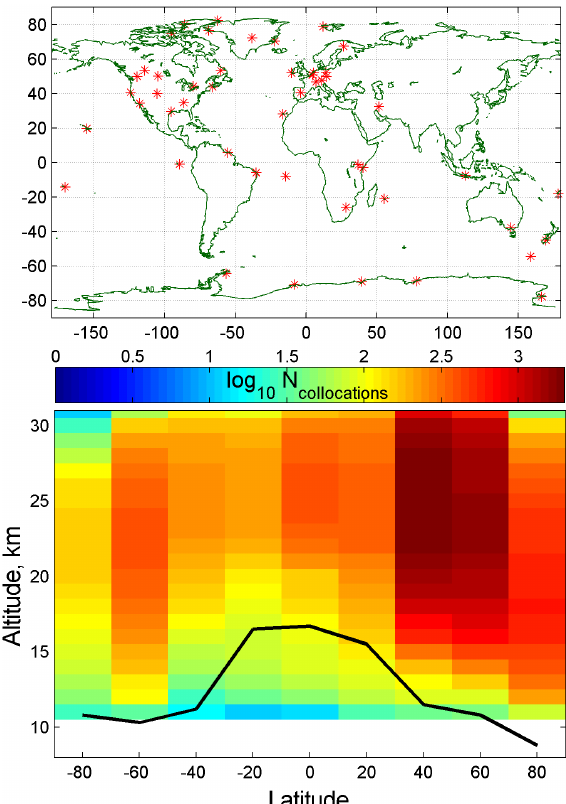
Figure 1. Top: locations of the ozonesonde stations considered in the comparison. Bottom: number of collocated measurements (log- arithmic color scale) in 20 ◦ latitude zones. The black line indicates the mean tropopause